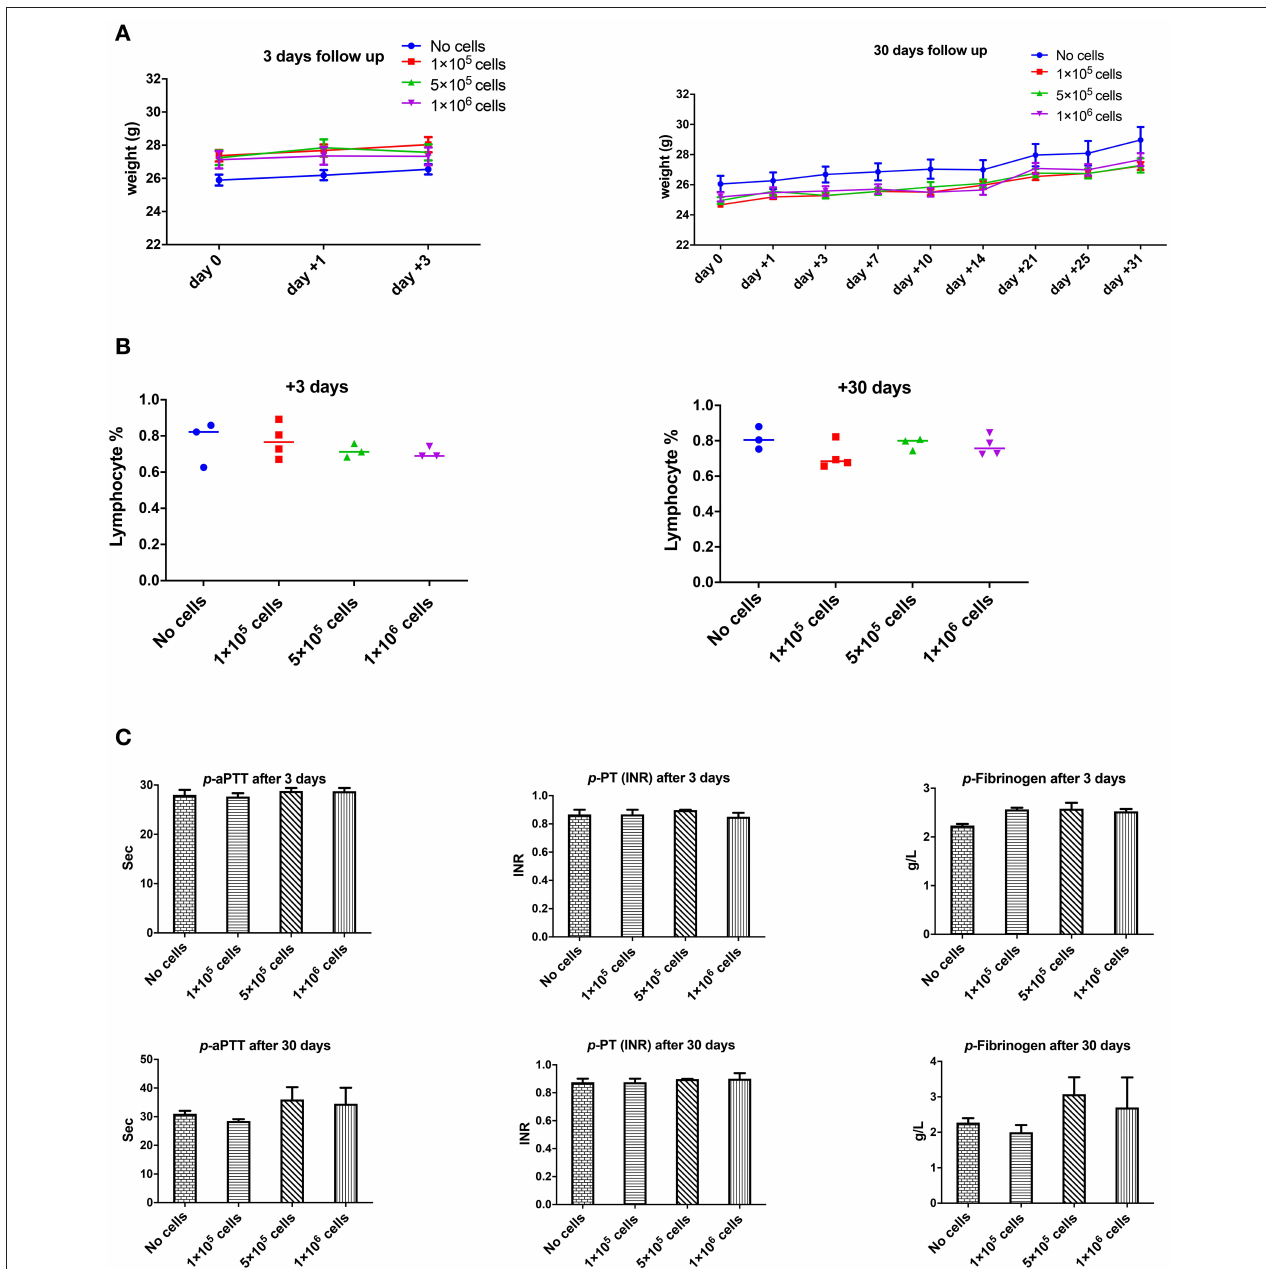
FIGURE 2 | The effect of human DSCs infusion on the mice weight, blood and coagulation system. To evaluate the clinical and biological changes in animals, human DSCs were infused i.v. at different doses (0–1 × 10 6 cell/mouse). The outcome was measured in short ( + 3 days after) or long term ( + 30 days after) follow up ( N = 3–5 mouse per dose/timepoint). (A) Weight and general health of treated animals was not affected by any dose in short and long term. (B) The frequency of peripheral blood lymphocyte did not change after human cell infusion. (C) Plasma level of coagulation factors was not influenced by the cell infusion as well.